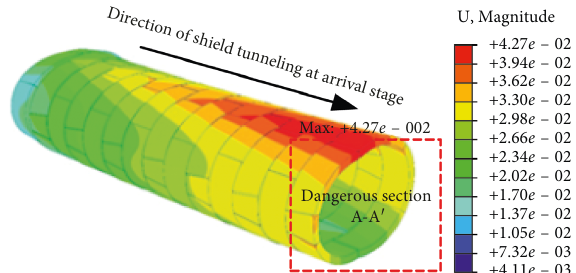
Figure 10: Extrusion deformation of segment (magnification 50 times).